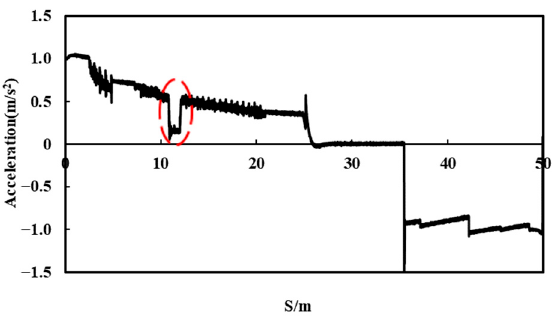
Figure 11. The whole acceleration of the train when the fault occurs during acceleration process. Assuming that a three-phase short-circuit fault occurs at the 35th segment in the left- side stator, of which the distance is 42 km, at this time, the train is decelerating. The stator currents and forces of the LLSM in two sides during the whole process are shown in Fig- ure 12. ( a ) ( d ) Figure 12. The current and thrust force of LLSM at two sides when the fault occurs during deceler- ation process: ( a ) thrust of the fault side LLSM; ( b ) thrust of the normal side LLSM; ( c ) current of the fault side stator segment; ( d ) current of the normal side stator segment. When the train passes through the fault segment during the deceleration process, the left-side LLSM is subjected to a braking force of 5.8 kN as circled in Figure 12a. The right- side converter is in the maximum output state, meaning it can provide a braking force of 110 kN. As circled in Figure 13, the deceleration decreases from 0.89 m/s 2 to 0.54 m/s 2 during the process. The deceleration can return to normal after the train leaves the fault segment and enters the next normal stator segment.